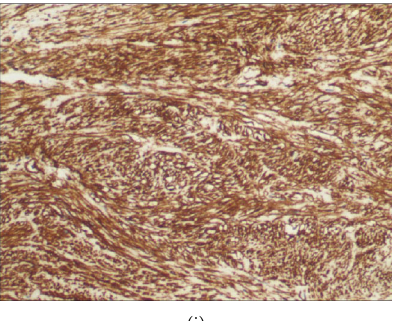
Figure 1: (a) Endoscopy showed that a suspicious protruding lesion was identi fi ed in the fundus of stomach. (b) A circumferential incision was produced, and a fundic tumor came into sight. (c) The tumor was resected thoroughly, leaving a big perforation. (d) The visceral organ appeared through the perforation. (e) The clip-with-line traction suture was applied. And the mucosal defect was sutured completely. (f) Haematoxylin and eosin (H&E) staining. Ampli fi cation factor: 100-fold. (g) Detection of CD34 protein expression by